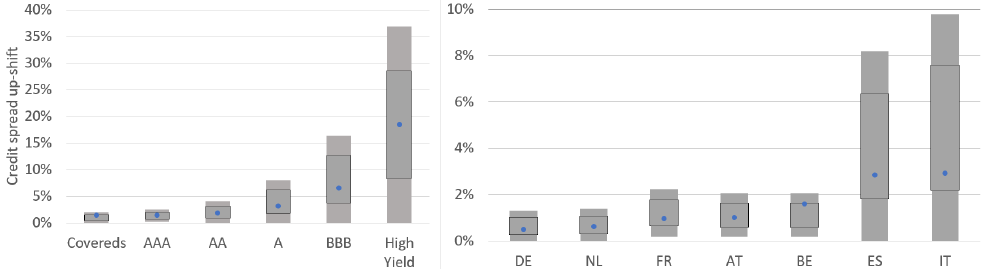
Figure 7. Comparison of the simulated shifts for the corporate and sovereign credit spread risk factors; representation based on our own results (blue dots) and EIOPA (2021a, pp. 25–26) (gray